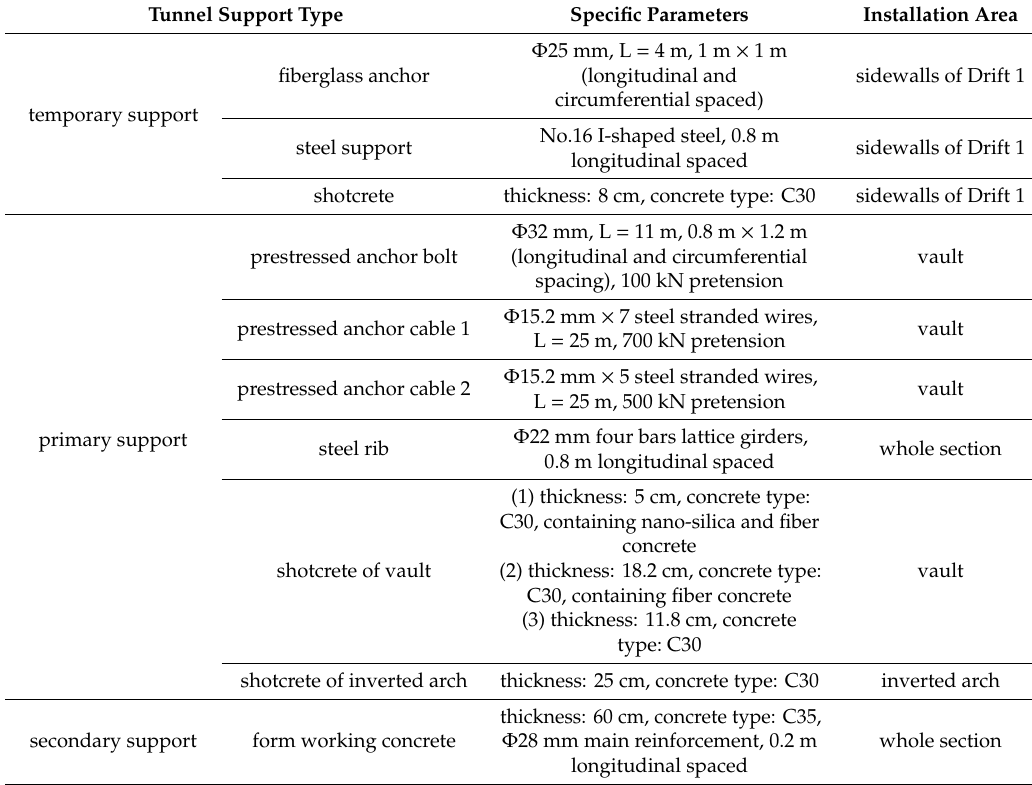
Figure 5. Support pattern and excavation process for Section 5–5. Table 4. Detailed parameters of the tunnel support for Section 5–5.